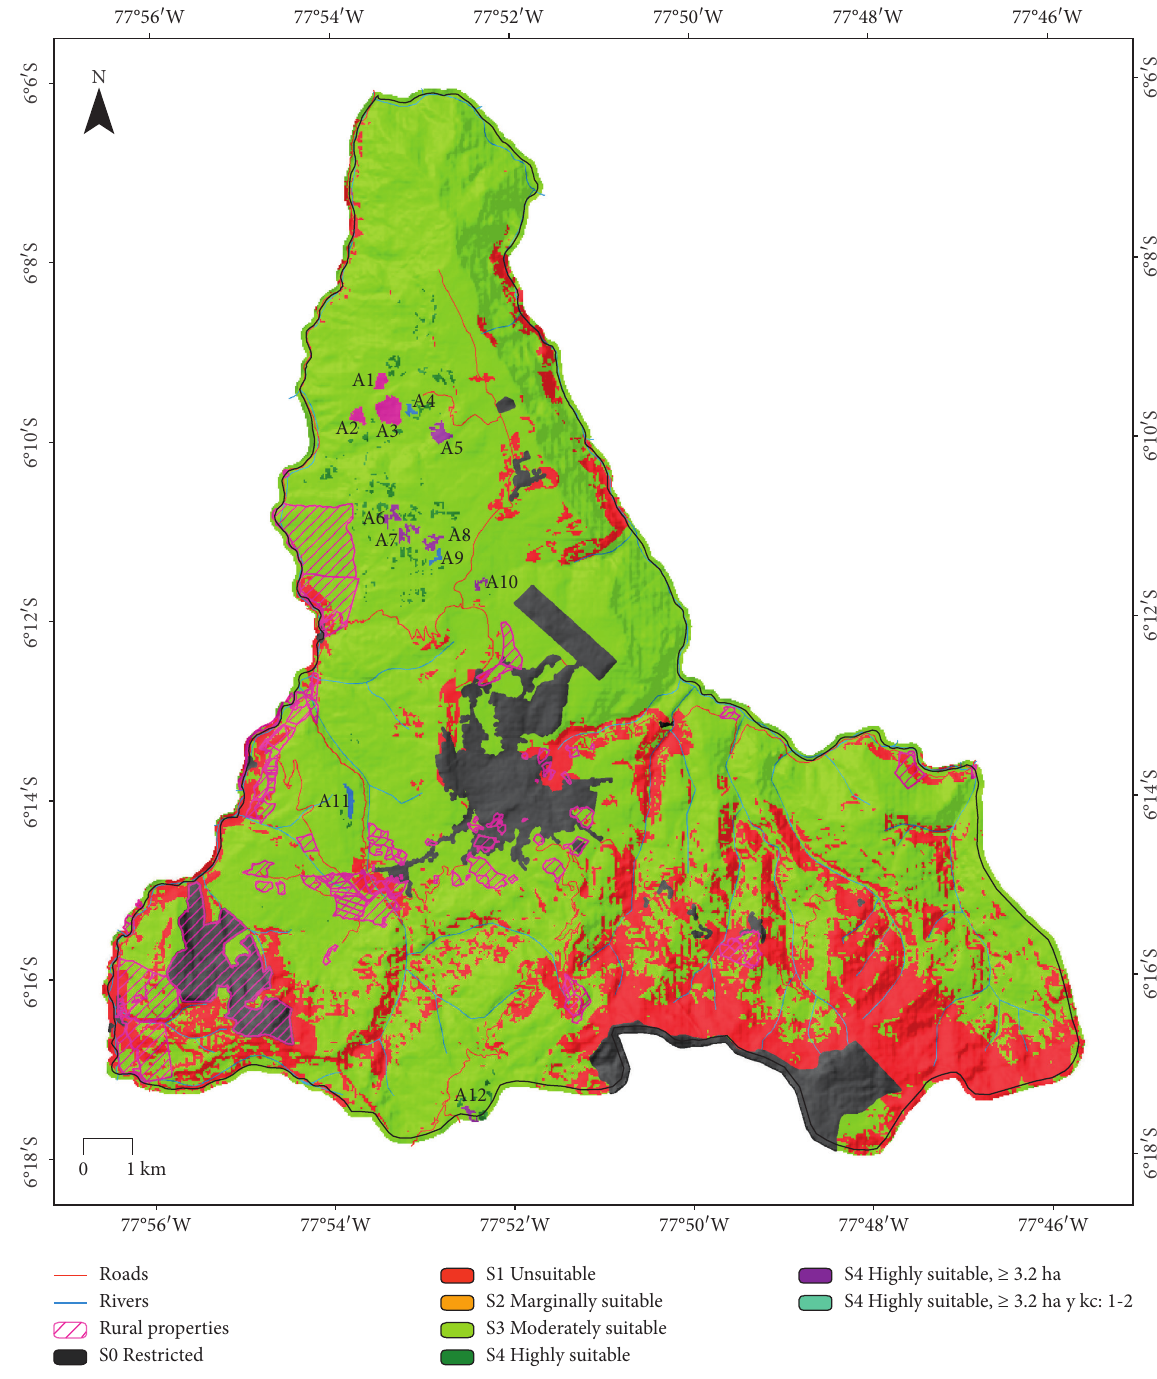
Figure 6: Suitability maps for potential sites for a Chachapoyas landfill, NW Peru. Table 8: Estimation of the minimum area for a future landfill in Chachapoyas, NW Peru, estimated with a useful service life (SL) for 20 years.